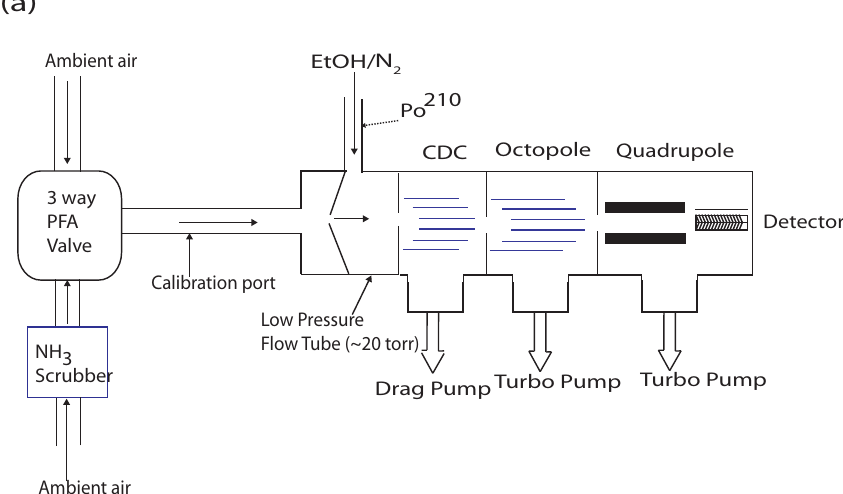
Fig. 1a. The NH 3 -CIMS system consists of the following three parts: (i) a sampling inlet used for ambient, background and calibration mea- surements, (ii) the CIMS flow reactor where ion-molecule reactions occur, and (iii) the vacuum regions of the mass spectrometer including a collision dissociation chamber (CDC), an octopole ion guide, a quadrupole mass filter and a channeltron